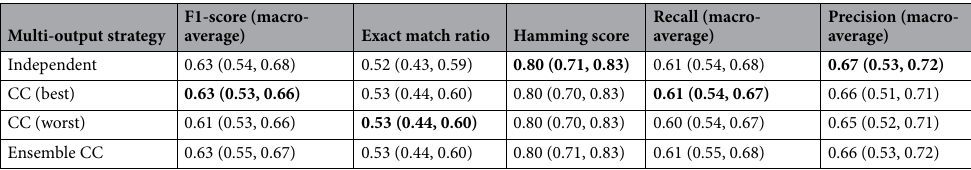
Table 1. Multi-output strategy benchmark. Median scores and overall ranges are reported for each strategy using the LDA classifier. Bold values indicate highest average performance for each evaluation metric.